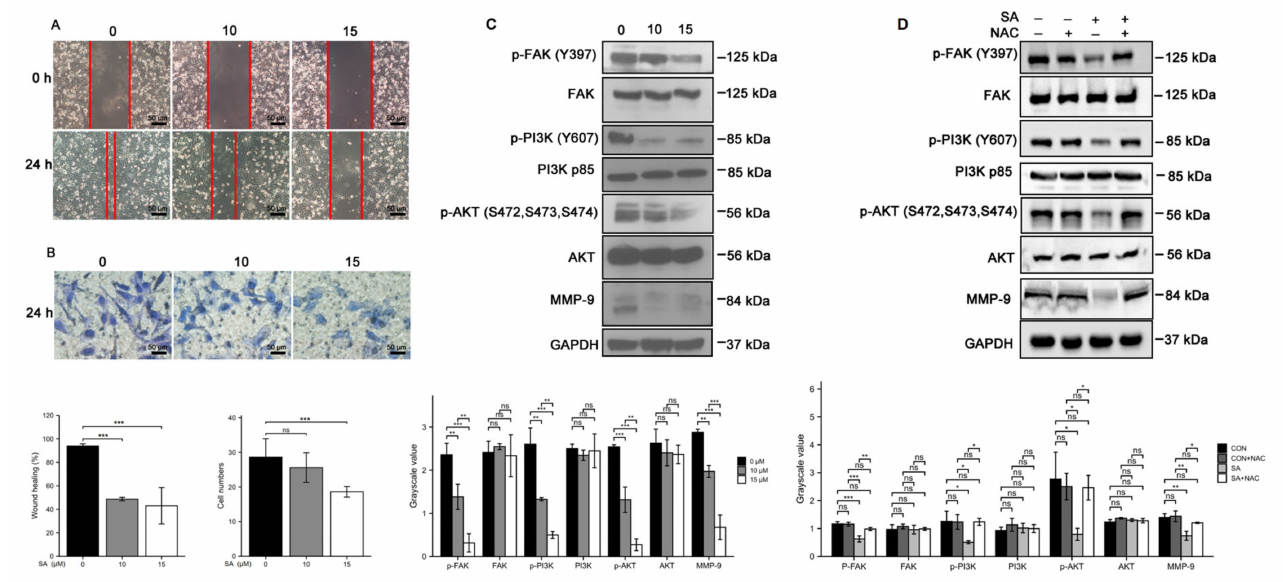
Figure 5. Scabertopin treatment inhibits the migratory and invasive ability of J82 cells by inhibiting the FAK/PI3K/Akt/MMP-9 signaling pathway, which can be rescued by NAC. Scabertopin significantly inhibits the migration ability (difference in area reduction between red lines) (n = 3) ( A ) and invasion of (n = 5) ( B ) of J82 cells treated with gradient concentrations of scabertopin for 24 h. ( C ) Phospho- FAK, phospho-PI3K, phospho-Akt, and MMP-9 expression levels significantly decrease in J82 cells after 24 h of scabertopin treatment. ( D ) Scabertopin-induced phosphorylation of p-FAK, p-PI3K, p-Akt, and MMP-9 expression can be reversed by NAC. A total of 5 µ M of NAC was used in the experiments. The grayscale values are normalized to GAPDH. Data are presented as the mean ± s.e.m. of the three independent experiments (n = 3). * p < 0.05, ** p < 0.01, *** p < 0.001, ns: no significance vs. 0 µ M scabertopin-treated group. AKT: Akt-protein kinase B; CON: control group; FAK: focal adhesion kinase; MMP-9: matrix metalloprotease-9; NAC: N-acetylcysteine; p-: phosphorylated; PI3K: phosphoinositide 3-kinase; SA: